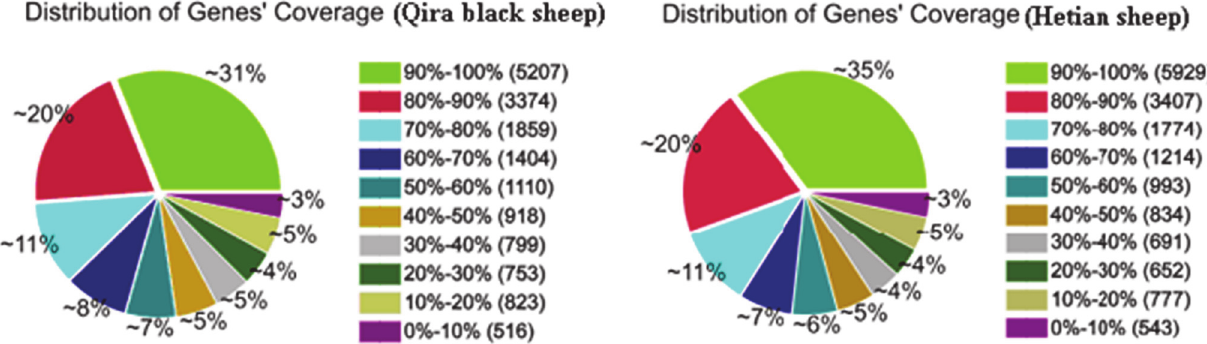
Fig 2. Distribution of genes 0 coverage in the two ovine libraries. Gene coverage is the percentage of a gene covered by reads. This value is equal to the ratio of total base count in a gene covered by uniquely mapped reads to the total base count for that gene.